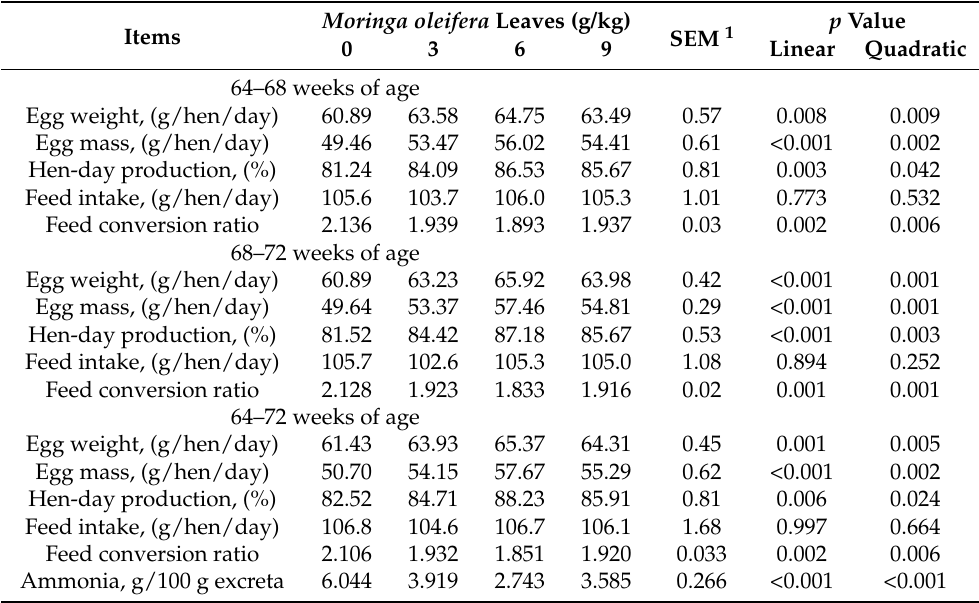
Table 3. The effect of Moringa oleifera leaves on the productive performance of laying hens during the late laying